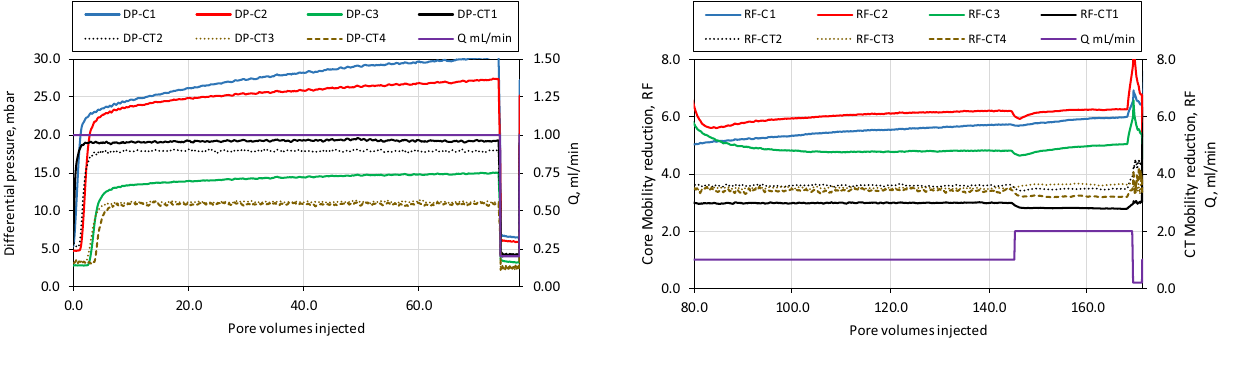
Fig. 5 Experiment 1b. 1000 ppm A06 in SSW in Bentheimer. RF as a function of pore volumes injected in Cores and capillary tubes (CT). T1 = 20 °C, T2 = 60 °C and T3 = 80 °C. The volumetric injection rate is 1 ml/min for from 77.6 to 145 pore volume and 2 ml/min from 146 to 169 pore volumes and is thereafter decreased to 0.2 ml/min